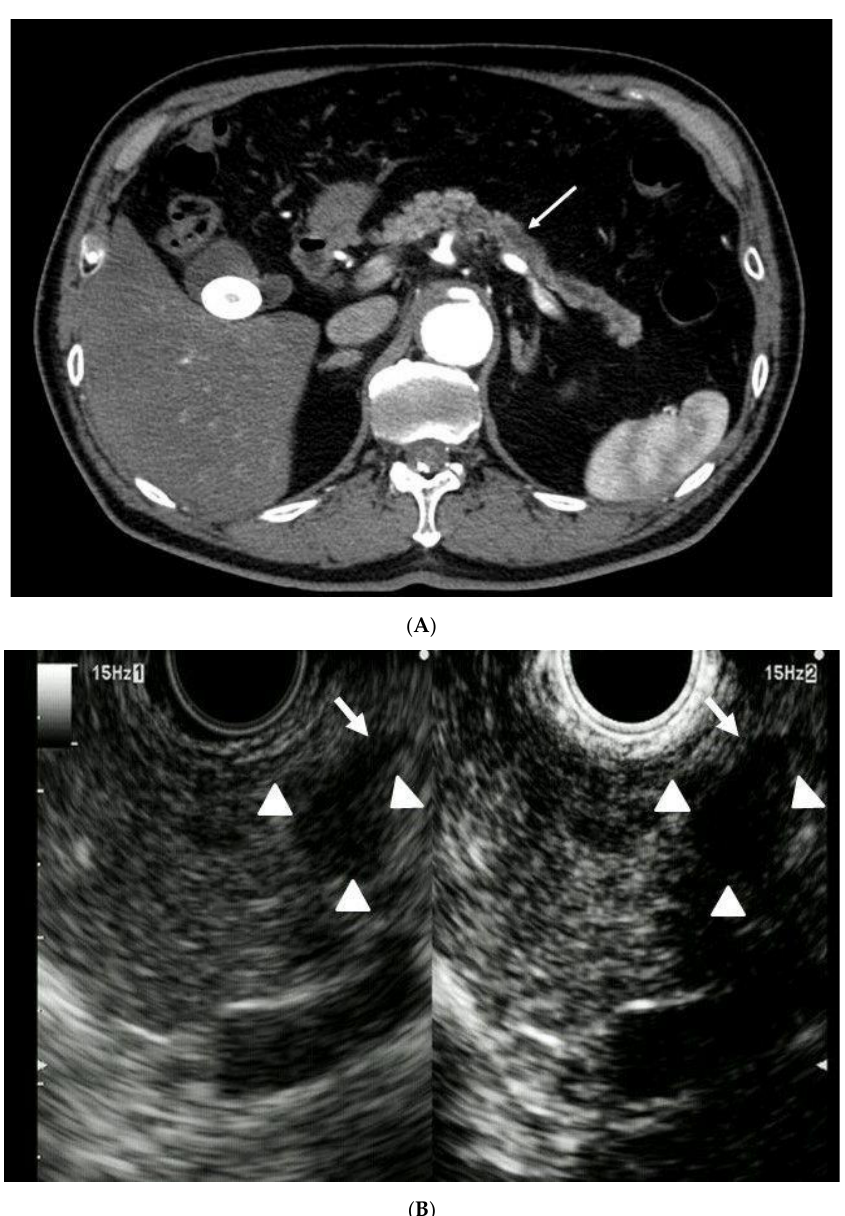
computed tomography; MRI, magnetic resonance imaging.